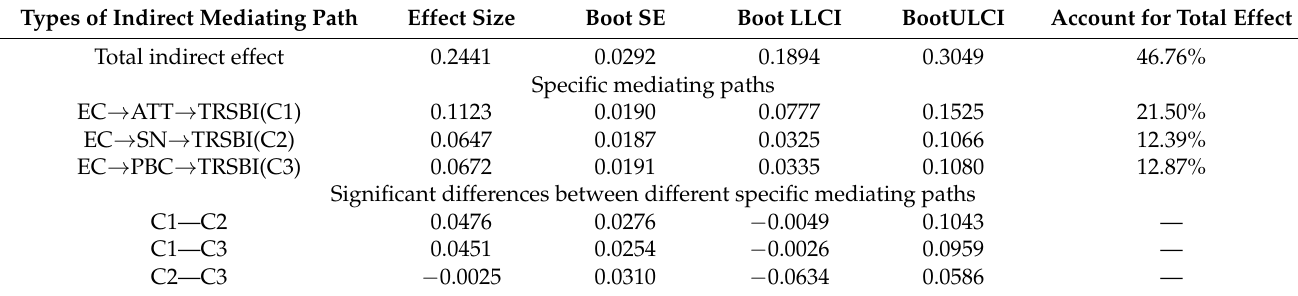
Table 4. Specific mediation analysis